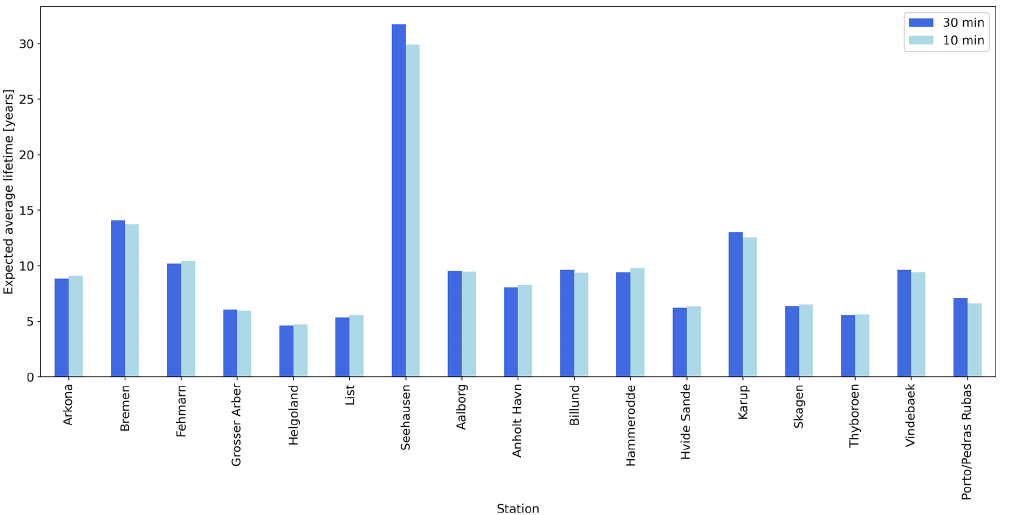
Figure 11. Blade lifetimes estimated using 30min accumulated rainfall intensities from the in situ stations and the native 10min rainfall intensities observed at the stations. Note that the Portuguese station Viana do Castelo/Chafé is left out due to a limited wind data availability.